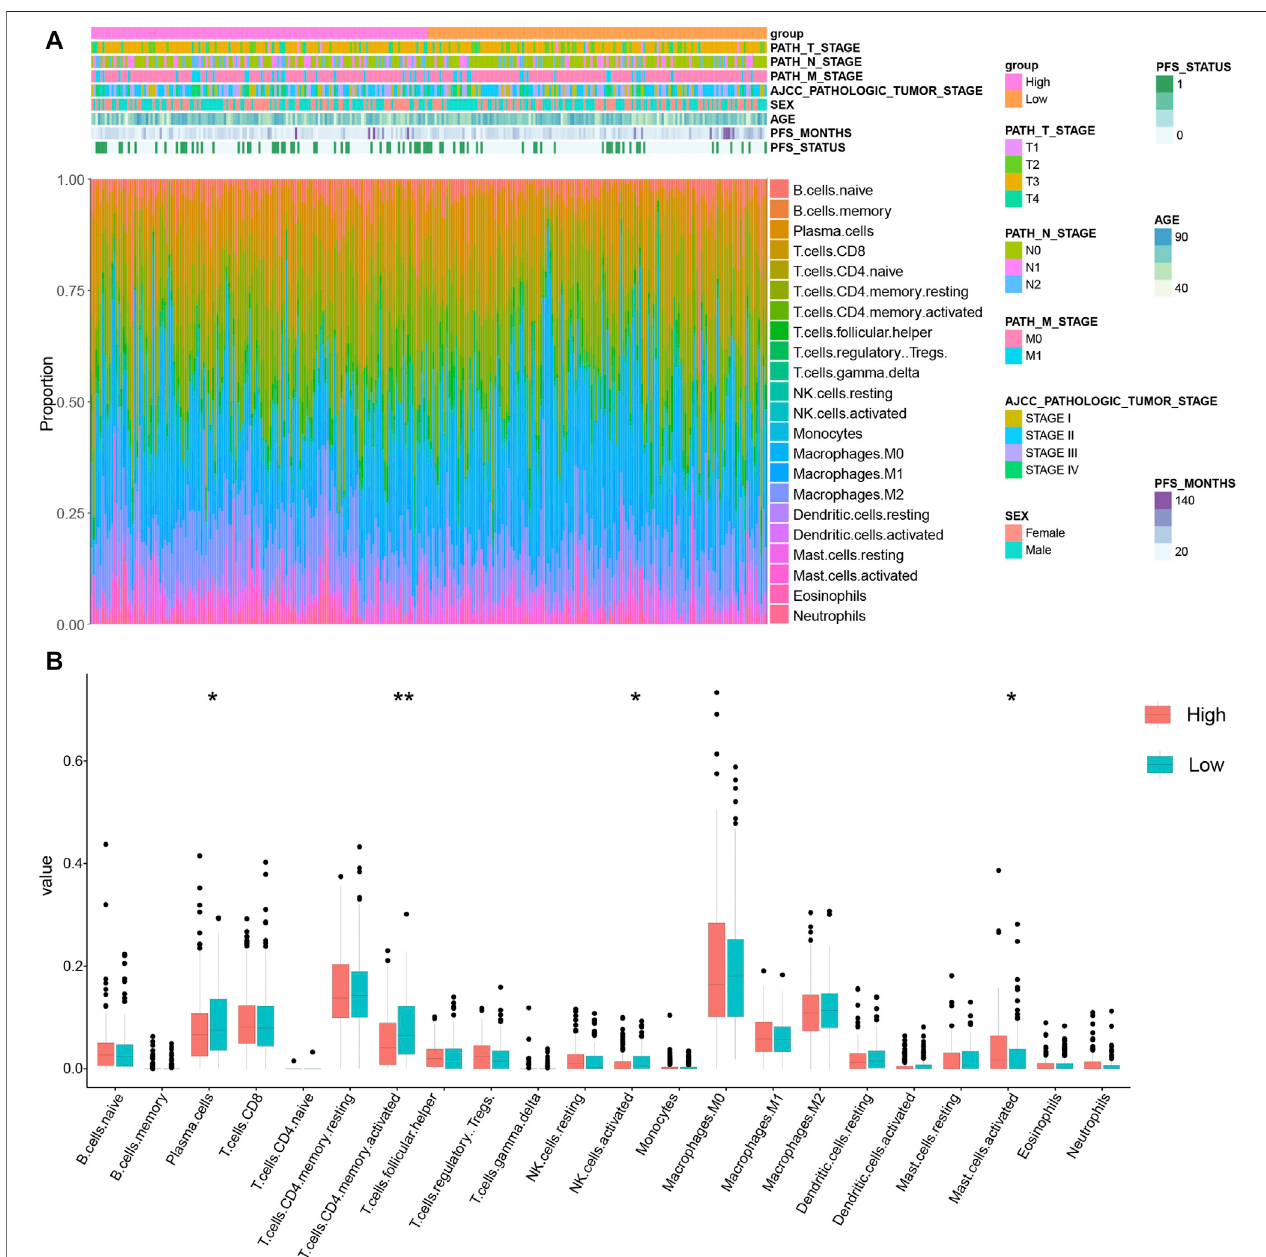
FIGURE6| Thedistribution ofin fi ltratingimmunecells inKRGPS subgroups. (A) Thelandscapeofthetumor immune environmentand clinicalfeatures ofpatients. (B) Levels of 22 in fi ltrated immune cells in KRGPS subgroups by Cibersort. * p < 0.05, ** p < 0.01, *** p < 0.001, **** p < 0.0001.